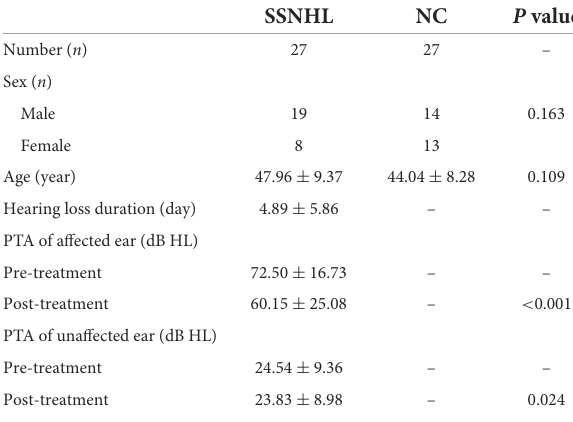
TABLE 1 Demographic and clinical